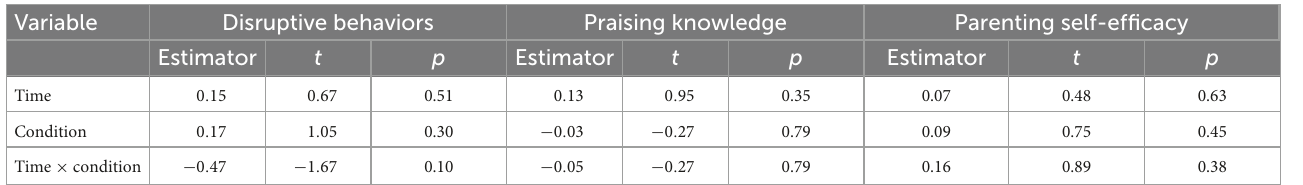
TABLE 4 Mixed-effects linear regressions.